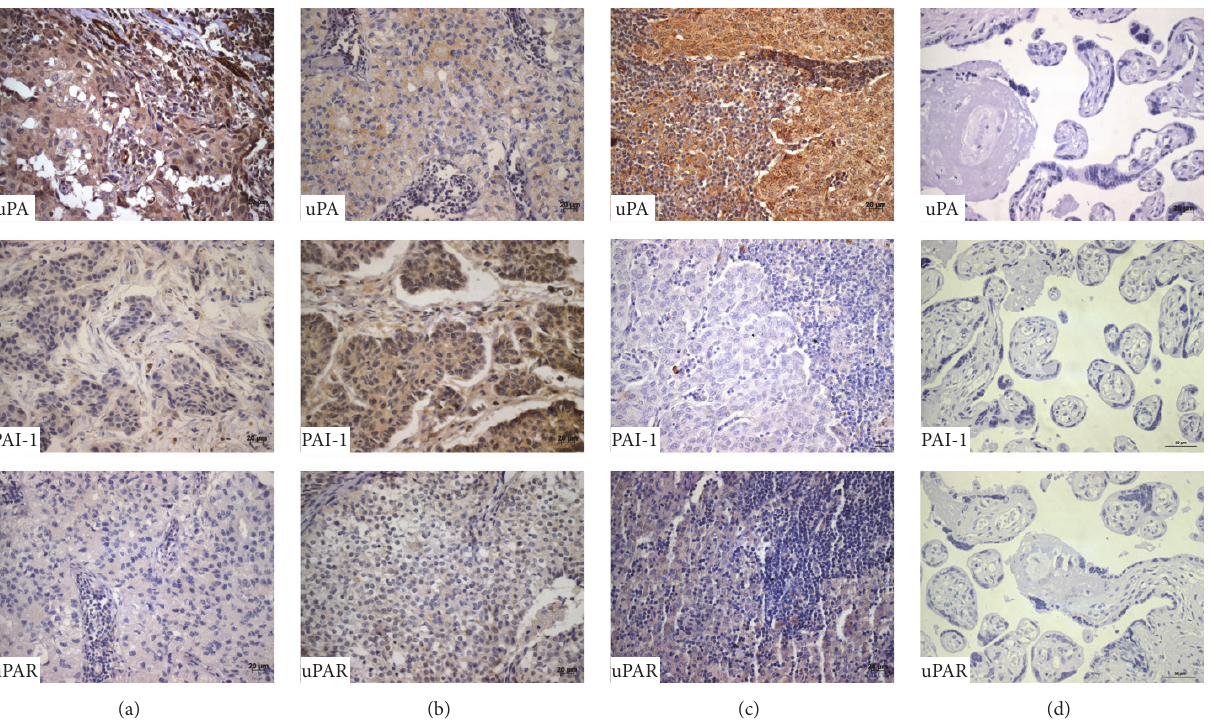
Figure2:Expressionoffibrinolyticsystemproteinsinsampleswithductalbreastcancer.Representativeimagesoftheimmunohistochemistry results of proteins from the fibrinolytic system uPA, uPAR, and PAI-1 in ductal breast cancer tissues with metastasis (a), without metastasis (b), metastatic ganglia (c), and negative controls (d). Magnification 400x.